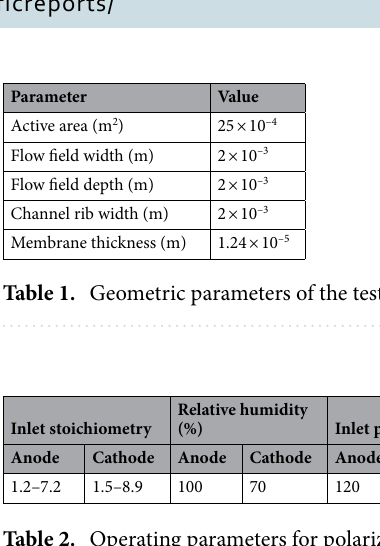
Table 2. Operating parameters for polarization